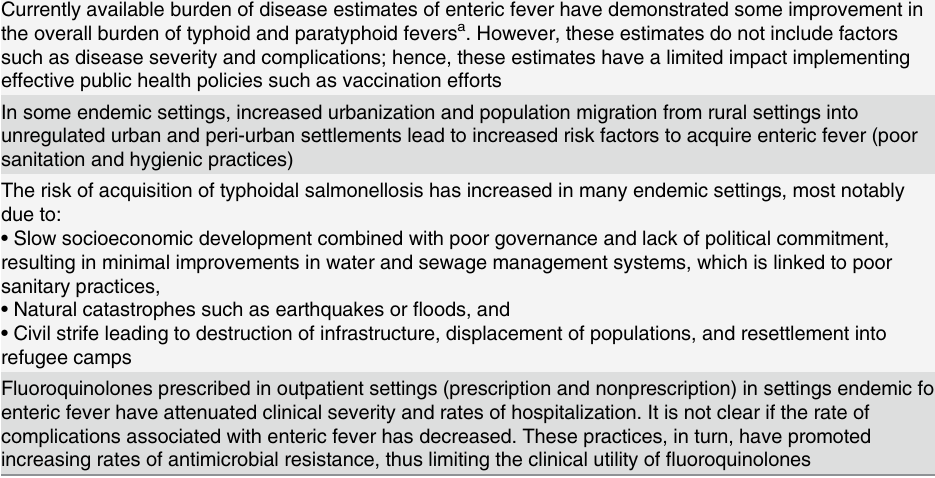
Table 1. Challenges in reducing the burden of disease of enteric fever (typhoid fever and paratyphoid fever). Currently available burden of disease estimates of enteric fever have demonstrated some improvement in the overall burden of typhoid and paratyphoid fevers a . However, these estimates do not include factors such as disease severity and complications; hence, these estimates have a limited impact implementing effective public health policies such as vaccination efforts In some endemic settings, increased urbanization and population migration from rural settings into unregulated urban and peri-urban settlements lead to increased risk factors to acquire enteric fever (poor sanitation and hygienic